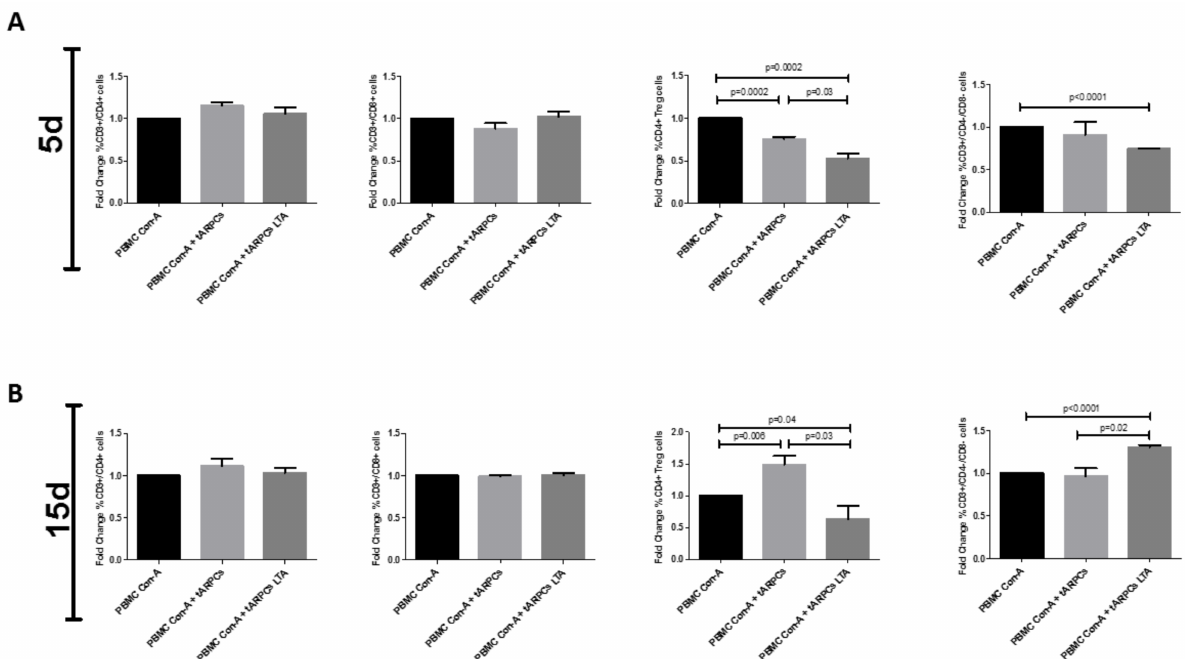
Figure 3. ARPCs are able to modulate Tregs and DN T cells. After 5 and 15 days of co-culture with ARPC or LTA-activated ARPCs, no changes were observed in both CD4 + T cells and CD8 + T cell subsets. After 5 days of co-culture, LTA acti-vated- ARPCs were able to significantly decrease the % of Tregs and DN T cells in Con-A activated PBMC ( A ). After 15 days of co-culture, LTA activated-ARPCs significantly decreased the % of Tregs and increased the % of DN T cells in Con-A activated PBMC ( B ). Data represent the fold change of the PBMC percentage respect to PBMC Con-A (basal). Data are representative of four independent experiments (means ± SEM).